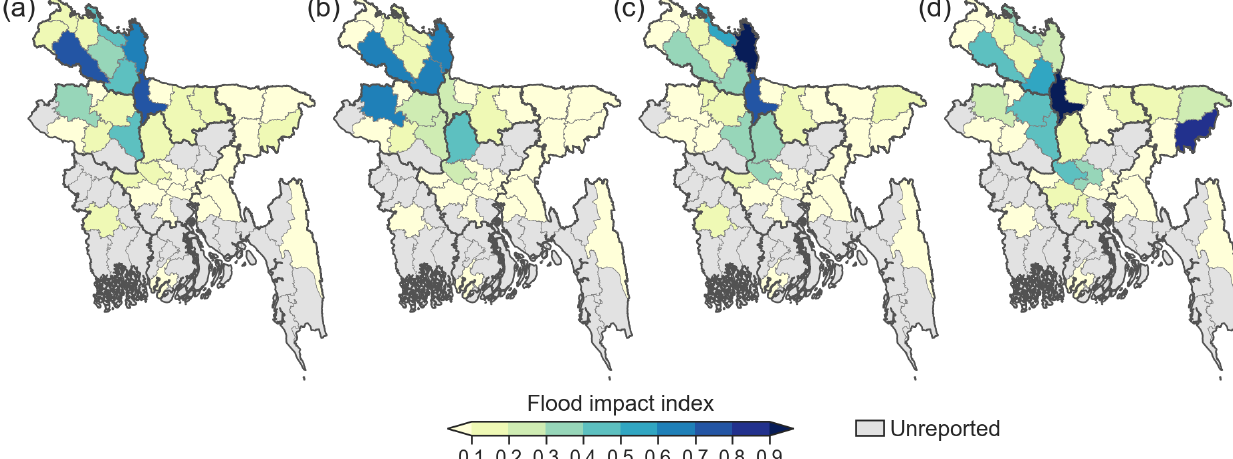
soon floods (ACAPS, 2014). At the Upazila scale (Fig.